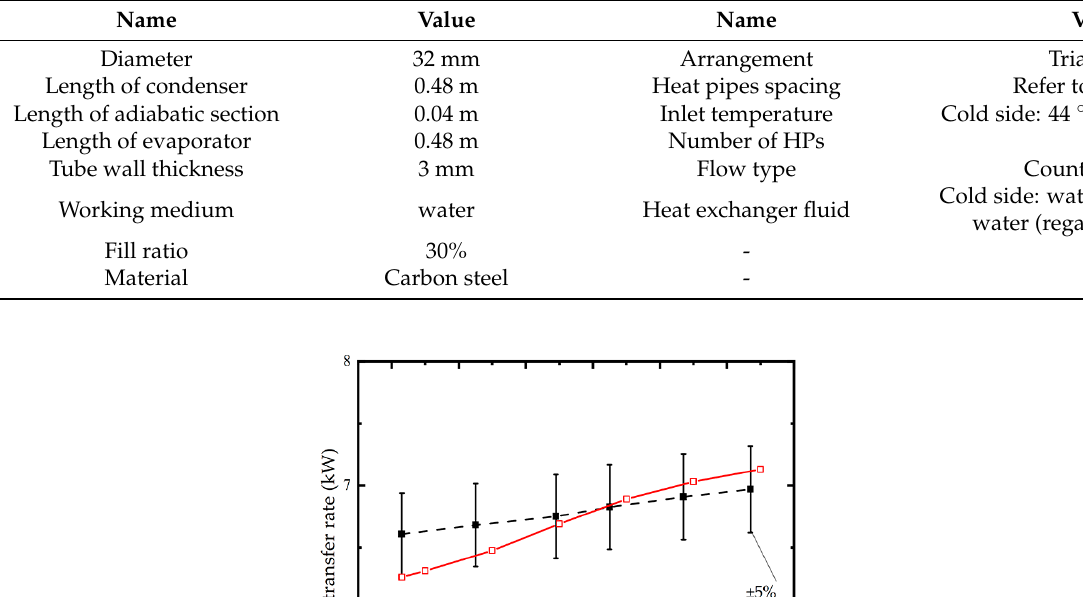
Table 1. The main parameters of heat pipe heat exchanger.